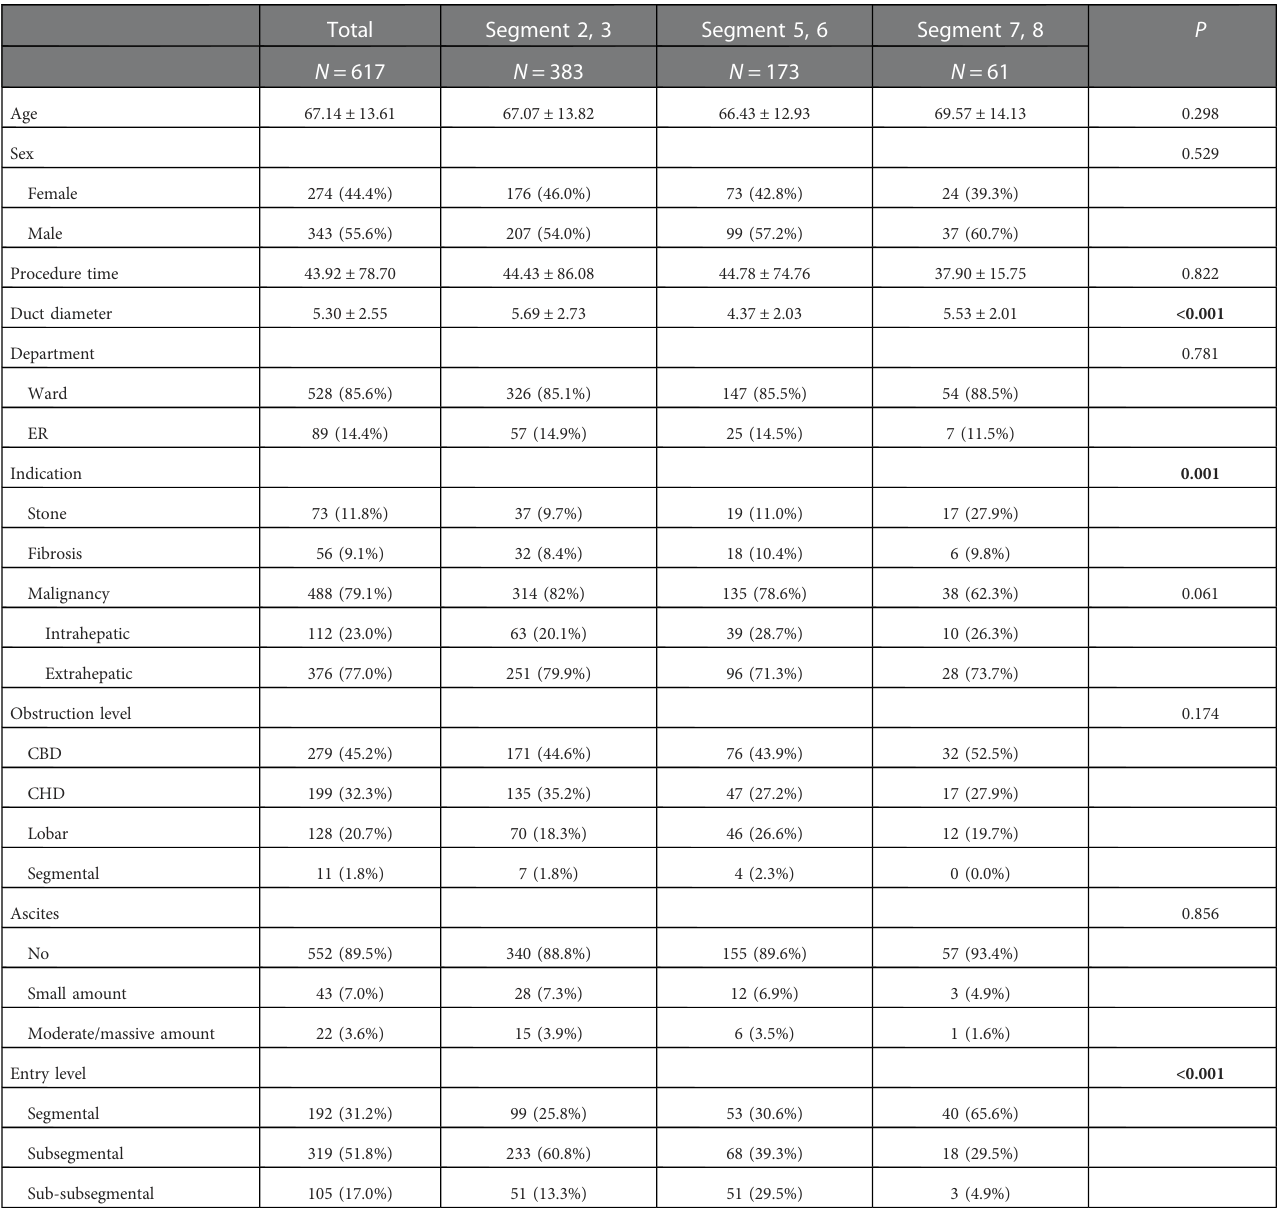
TABLE 1 Patient characteristics and surgical outcomes of